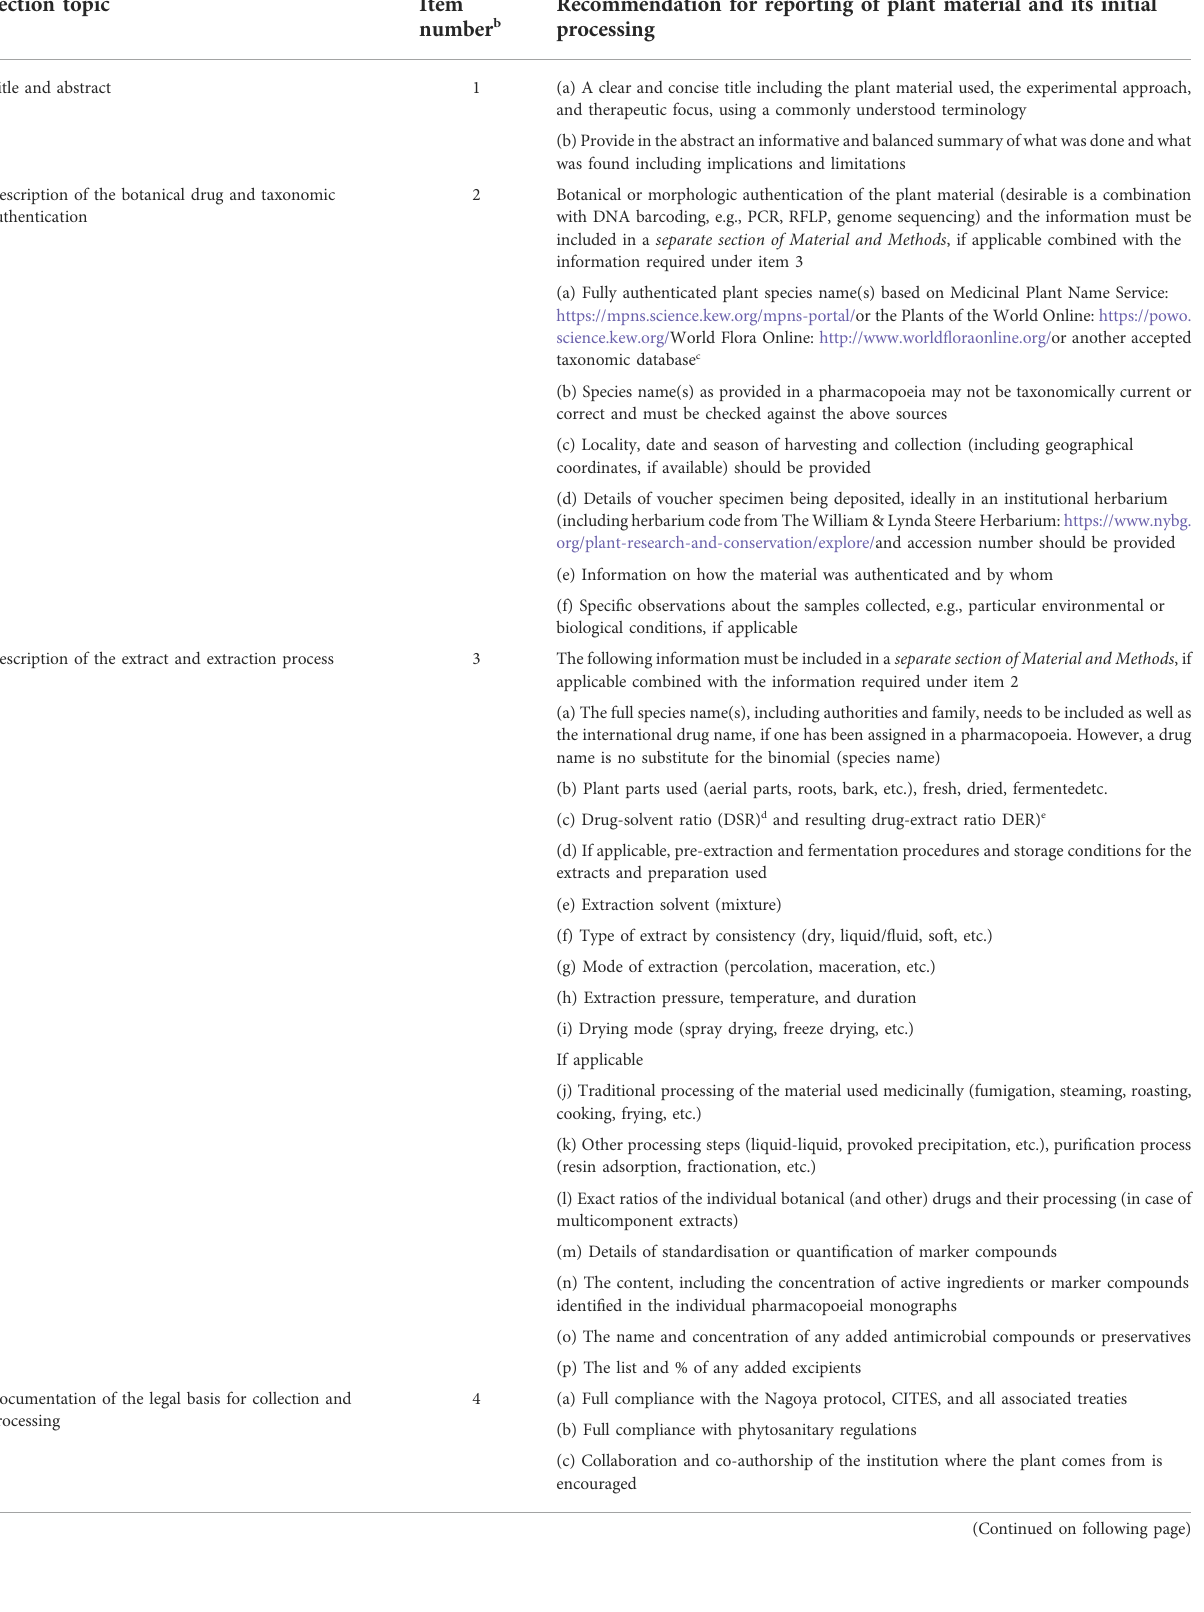
TABLE 3 Recommendations (checklist of items) for reporting of the starting plant material a and its initial processing and which should be used in conjunction with (Heinrich et al., 2020). Section